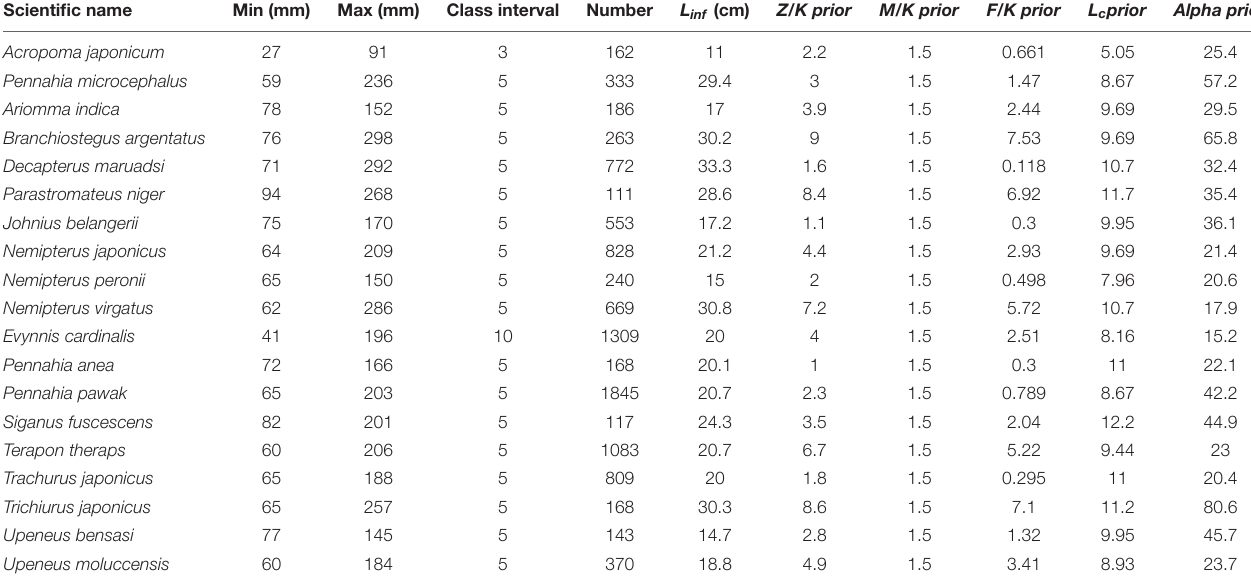
TABLE 1 | Basic information and priors of 19 species used in this present